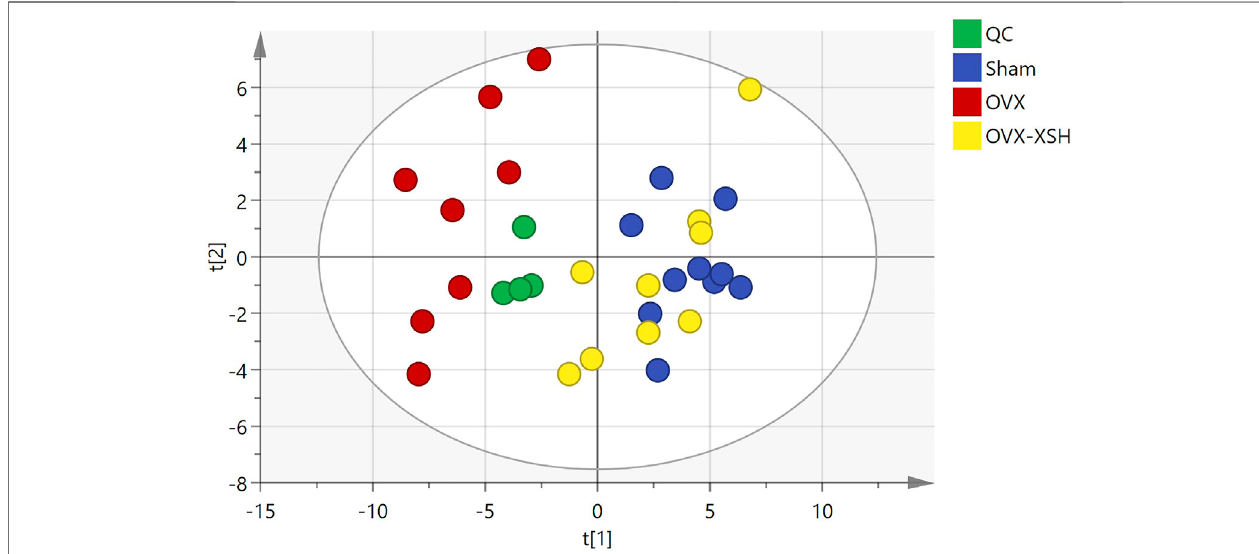
FIGURE 7 | Score plot of PCA. n (cid:2) 8 – 10 per group, QC (quality control), and OVX-XSH (97.2 mg/kg).